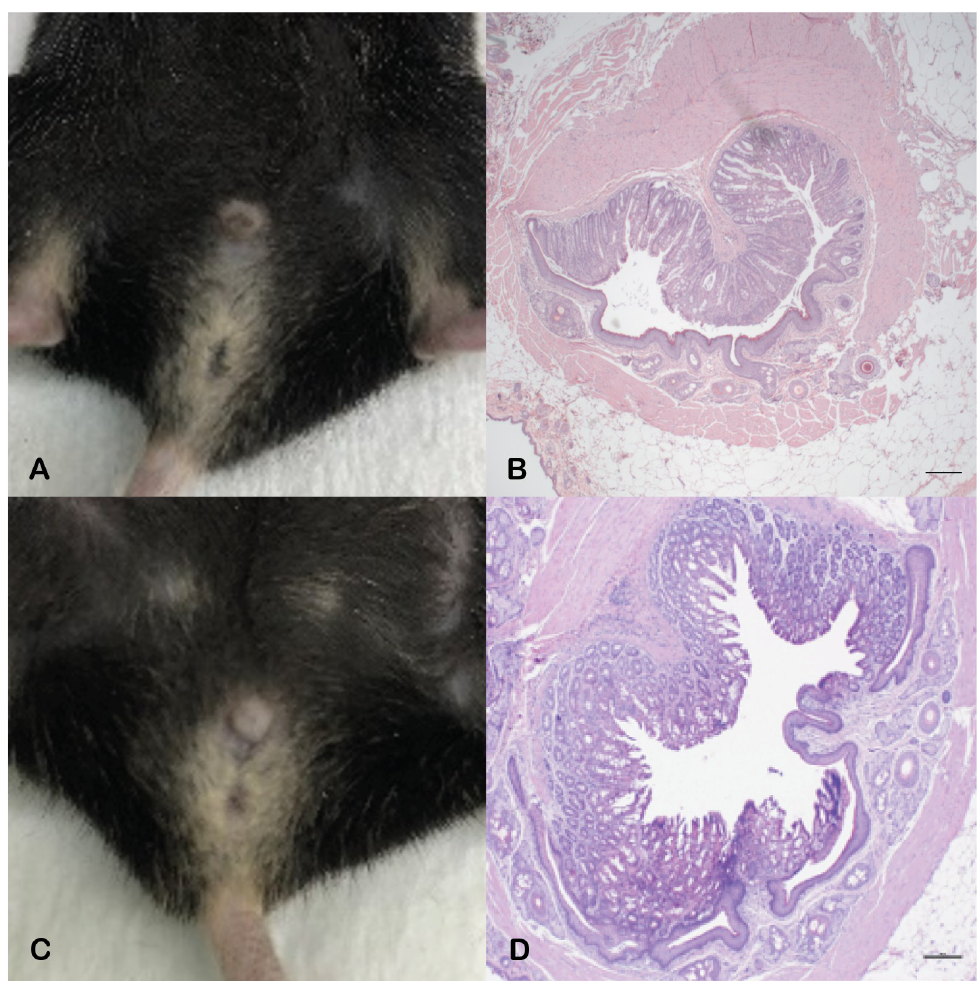
Fig 7. Castrated and ovariectomized KC mice and assessment for anal tumor. Male KC mice were castrated and female KC mice were ovariectomized at 6–7 weeks of age, and the anal tissue evaluated at age 9 months. Macroscopic examination revealed no abnormalities in castrated KC males and most ovariectomized KC females (representative images, A and C). Concordantly, histopathologic examination revealed no microscopic tumor formation in male KC mice or macroscopically normal ovariectomized KC female mice (representative images B and D). Scale bars equal 100 μ m.